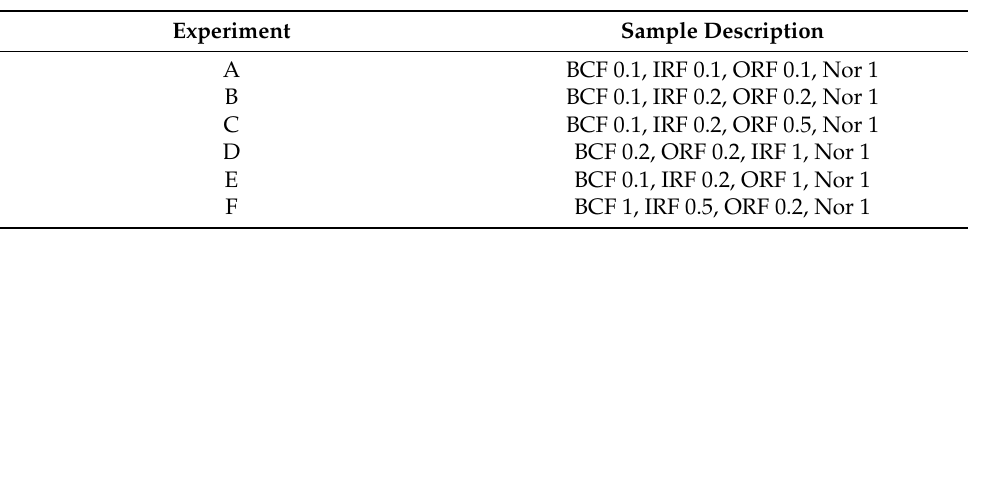
Table 4. Experiment description of multi-class imbalanced